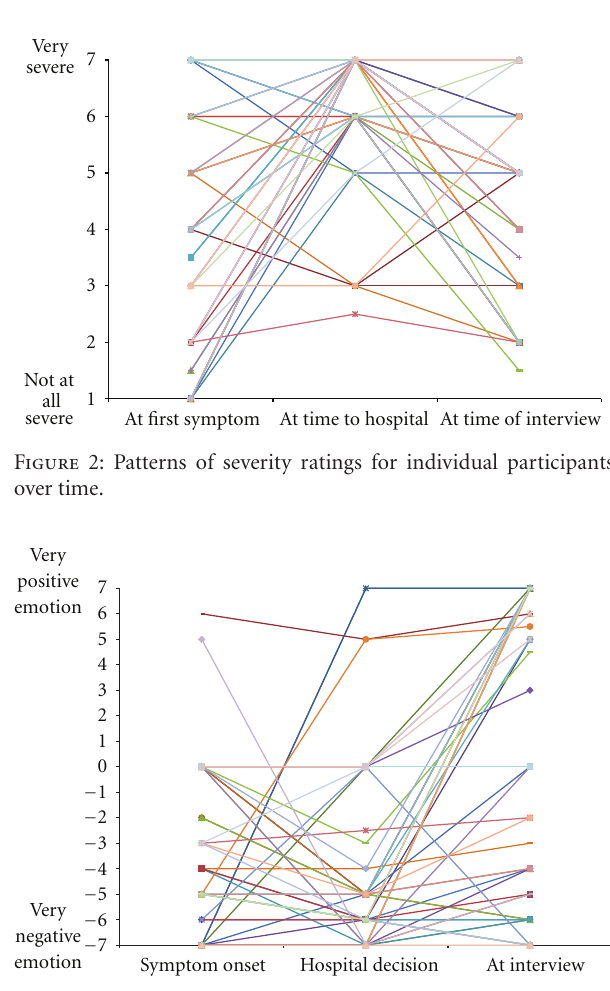
Figure 3: Patterns of emotional valence for individual participants over